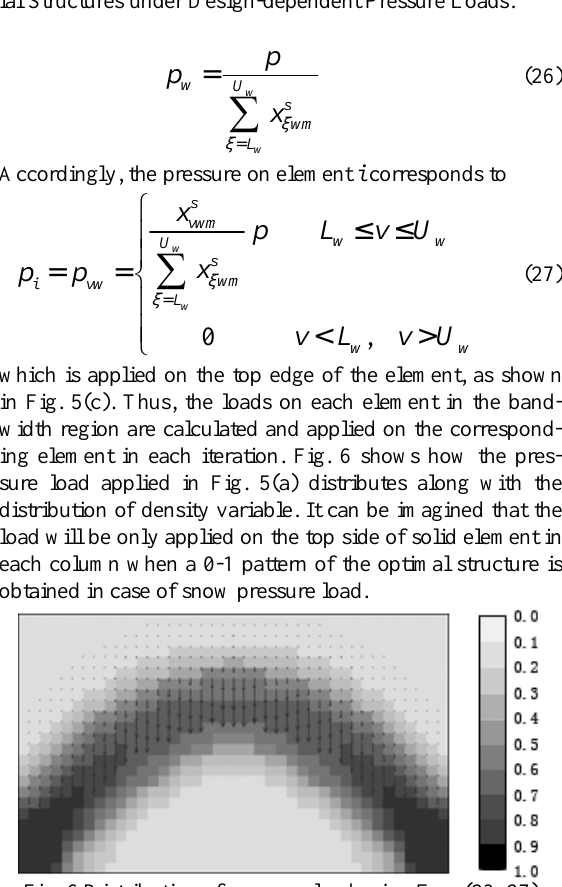
Fig. 6 Distribution of pressure load using Eqs. (23,